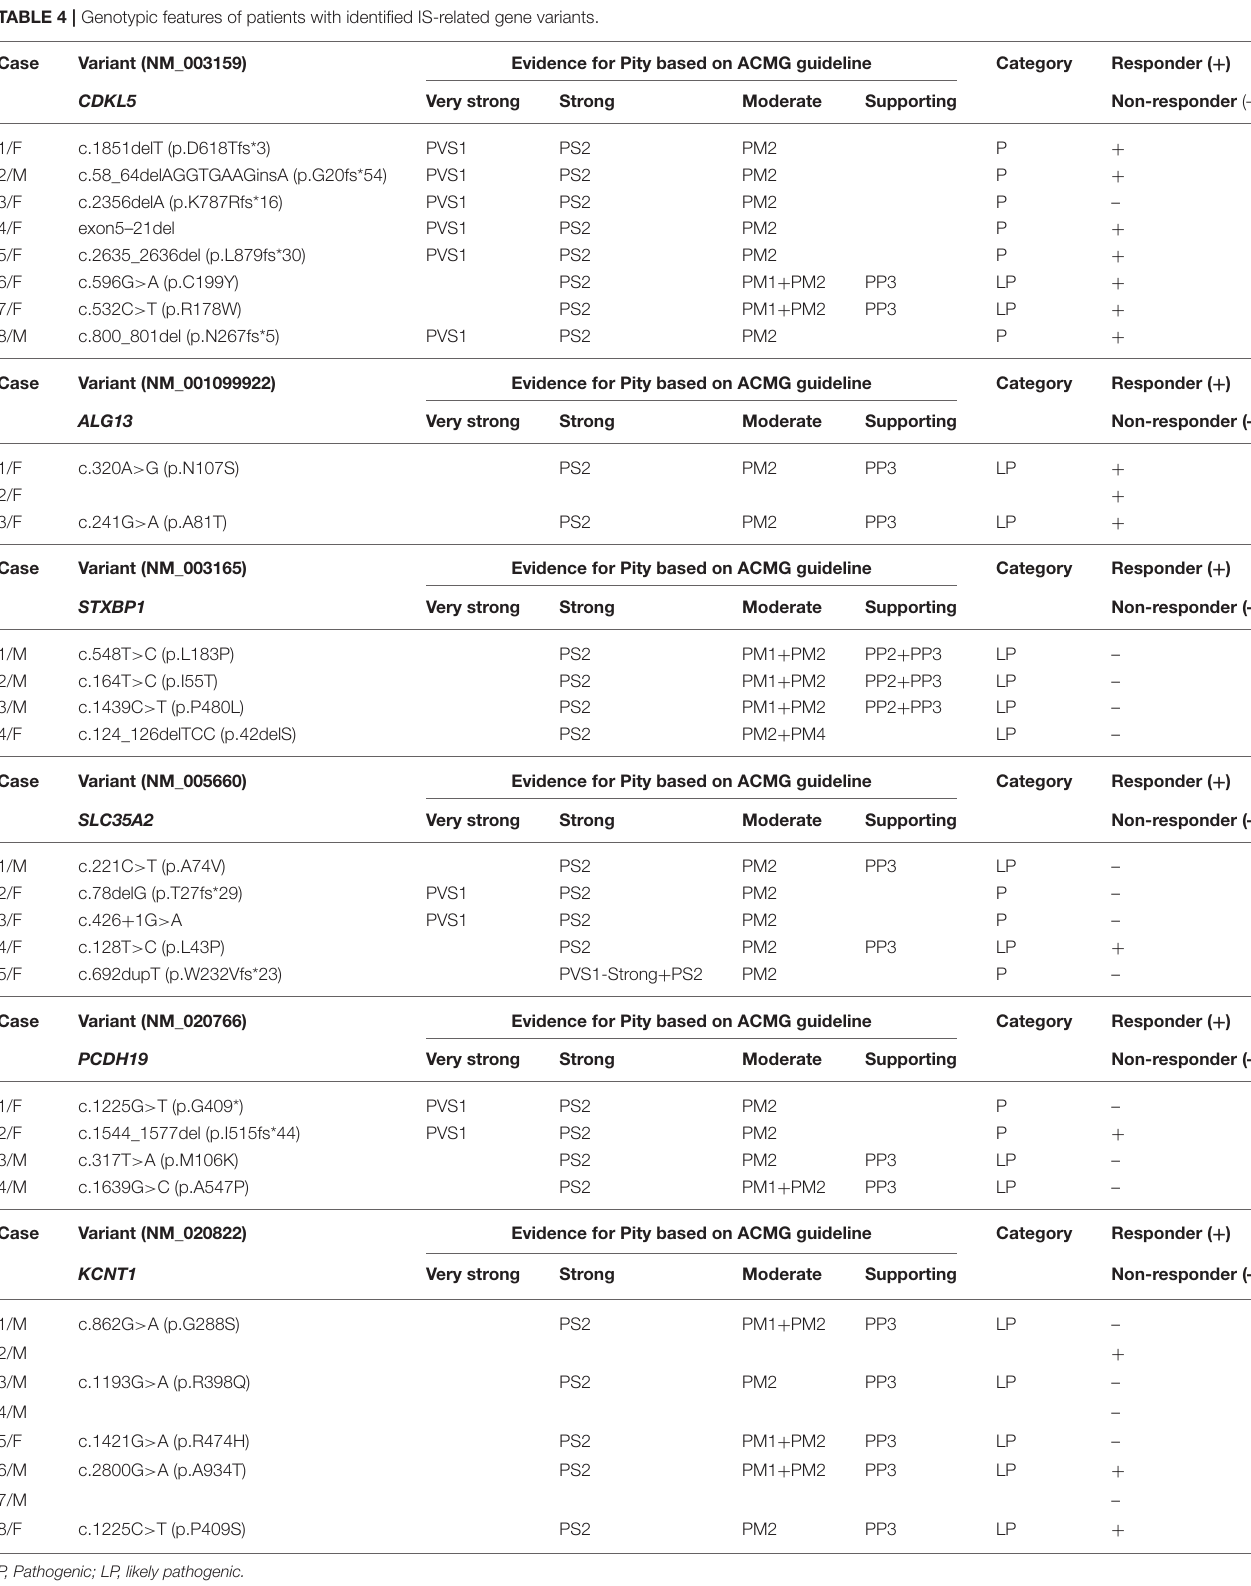
TABLE 4 | Genotypic features of patients with identified IS-related gene variants.